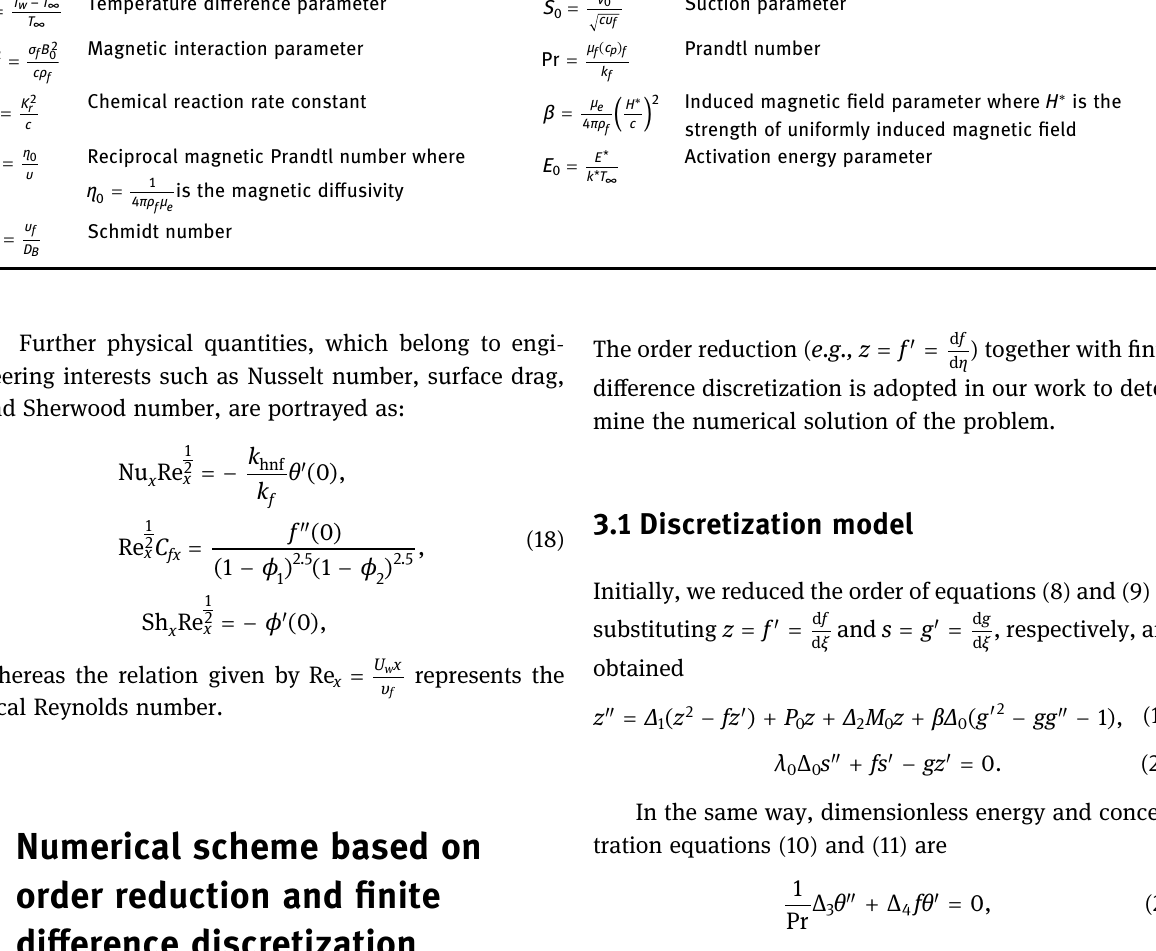
Table 2: The preeminent parameters Temperature di ff erence − w ∞ = δ T T T ∞